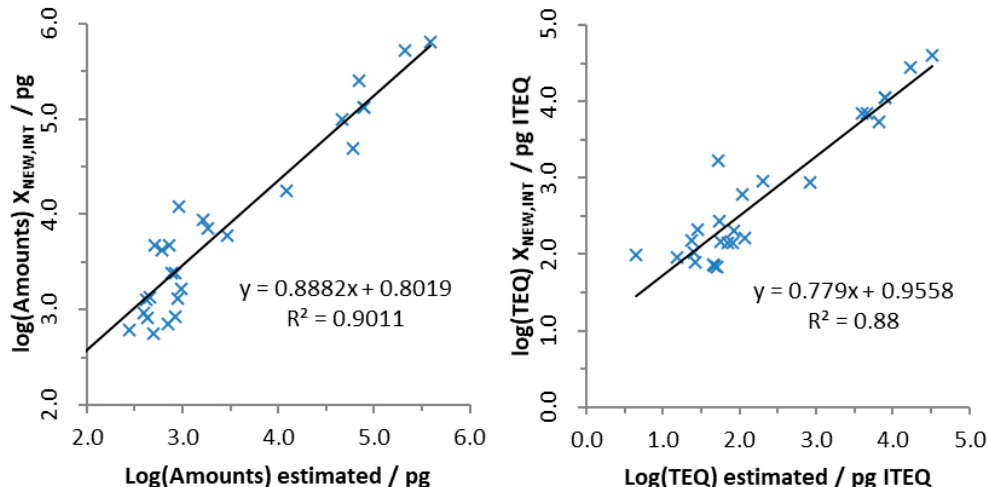
Figure 1. Total amounts estimated from previous model 1 ( left ) and total toxicity estimated from previous model 2 ( right ) using 𝕏 NEW,INT dataset.